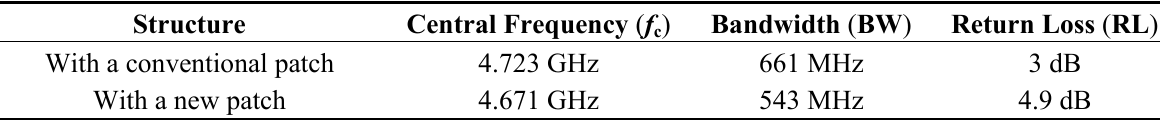
Table 7. Comparison between the performance of both dual-mode filters considering ε = 3.06 and tan δ = r ‖ ‖